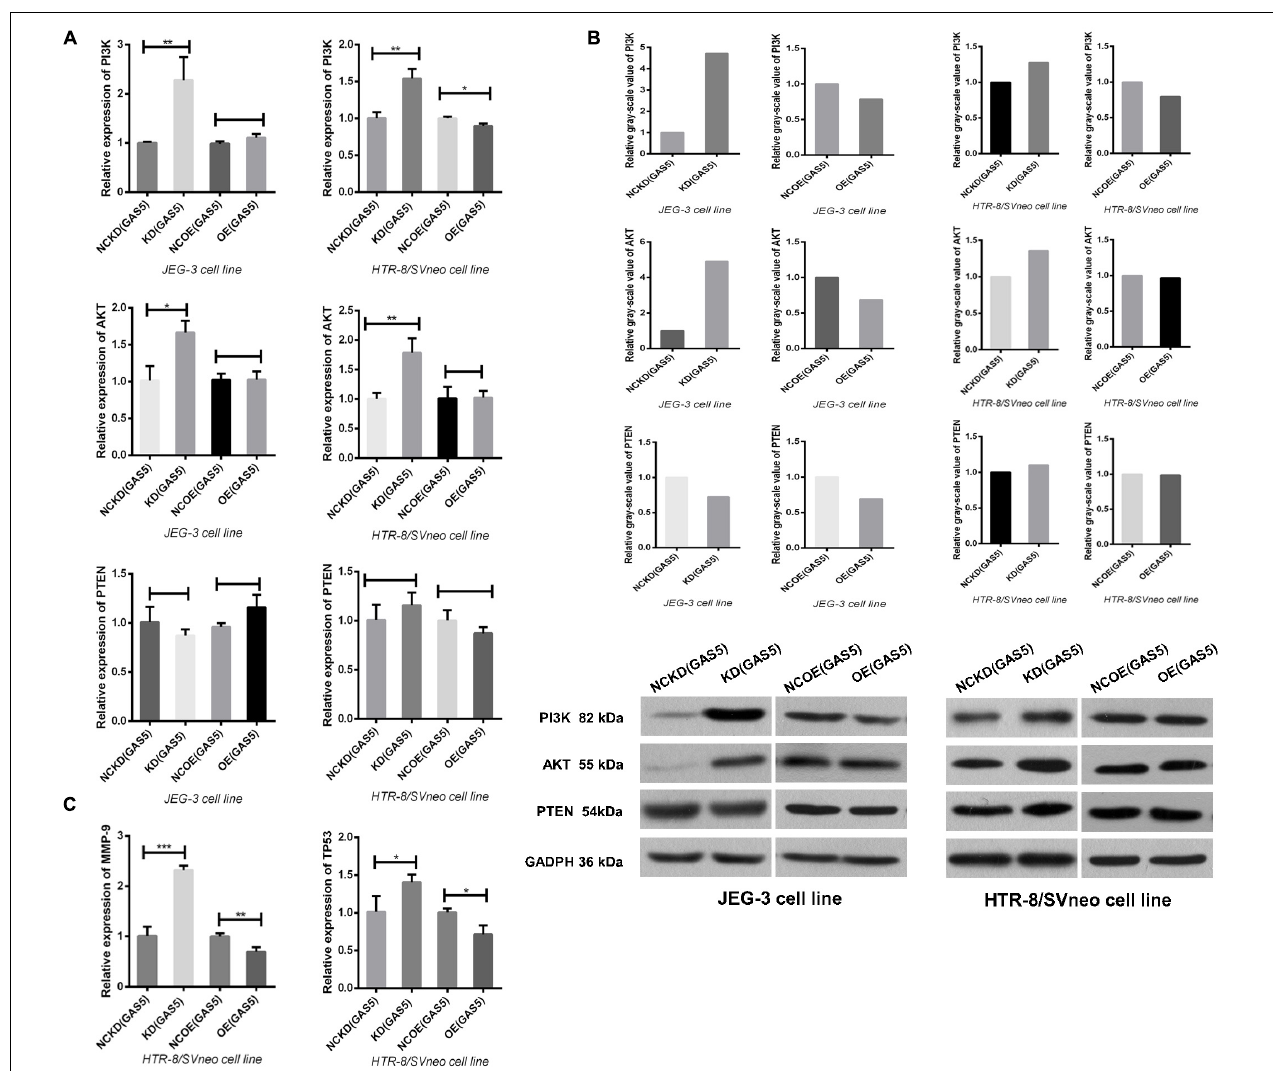
FIGURE 6 | (A) Knockdown GAS5 promoted the activation of PI3K/AKT signaling pathway in the two cell lines. In HTR-8/SVneo, overexpression of GAS5 only inhibited the activation of PI3K not involving AKT, while in JEG-3, the PI3K/AKT pathway is not changed. All were analyzed by qRT-PCR assay. (B) We also detected the effect of GAS5 on PI3K/AKT pathway by Western Blot. In the two cell lines, knockdown GAS5 promoted the activation and overexpressed GAS5 inhibited this pathway except that the AKT in HTR-8/SVneo was not altered after GAS5 overexpressed, as same as the results detected by qRT-PCR in (A) . The PTEN, which was suggested as a target gene of GAS5, was not altered by the two means (A,B) . (C) The expression of downstream proteins involving MMP9 and TP53 were all elevated after GAS5 knockdown and declined after GAS5 overexpression, which were coincident with the variation of PI3K/AKT signaling pathway in HTR-8/SVneo, verified by qRT-PCR. * P < 0.05, ** P < 0.01, *** P <